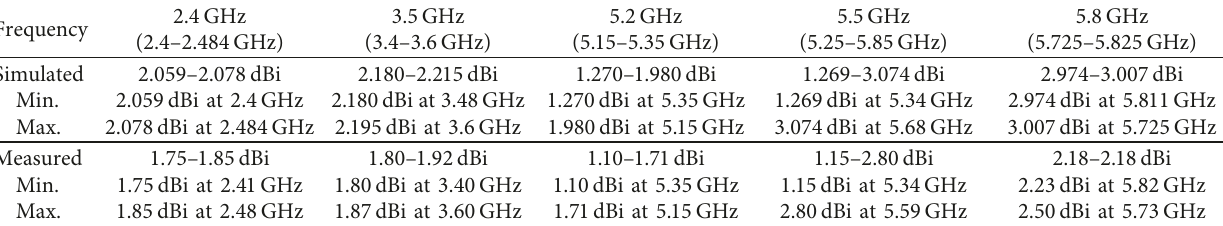
Table 4: Simulated and measured antenna